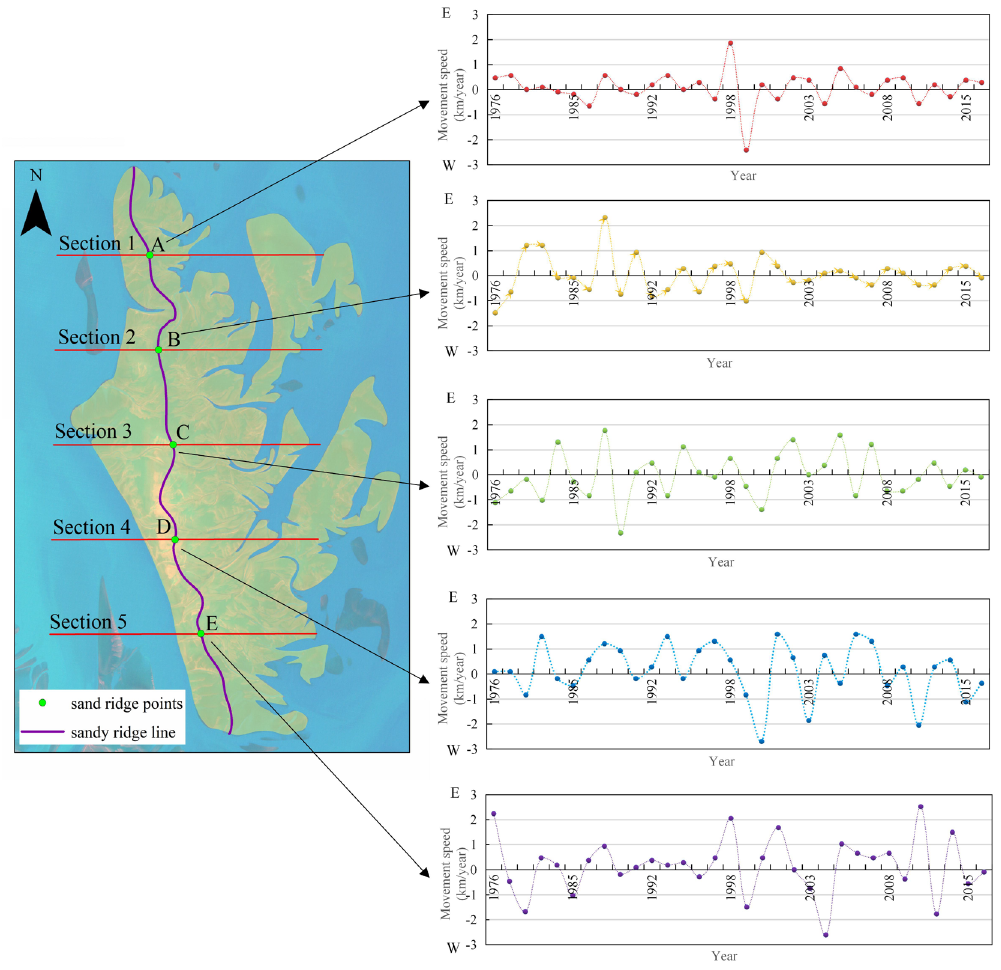
Figure 8. Velocity distribution of sand ridge points movement in different periods.